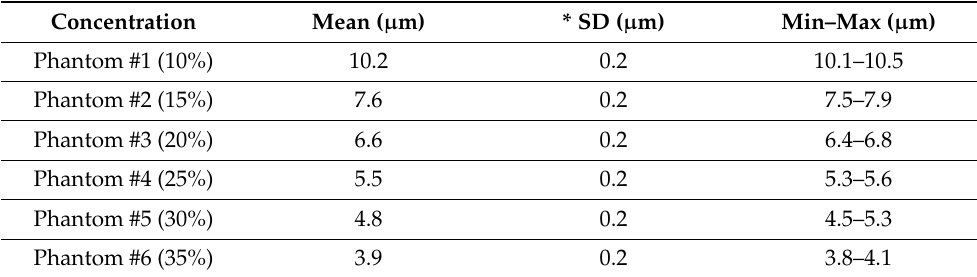
Table 4. Measured displacement induced by the acoustic radiation force. Concentration